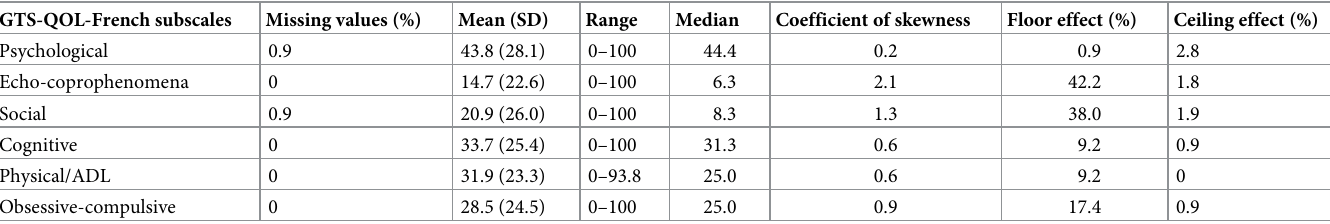
Table 4. Descriptive statistics and score distributions of the GTS-QOL-French subscales.